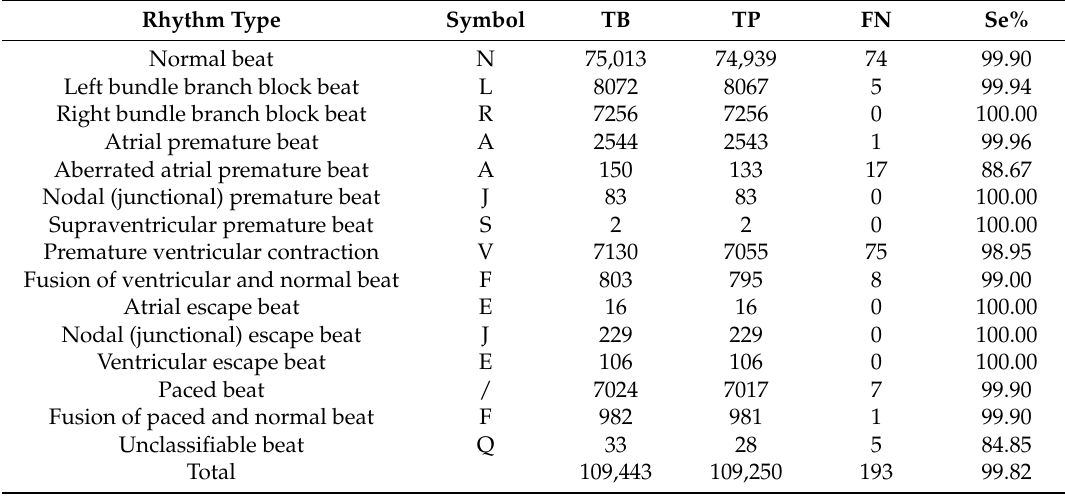
Table 2. Performance during different rhythms using the MIT-BIH arrhythmia